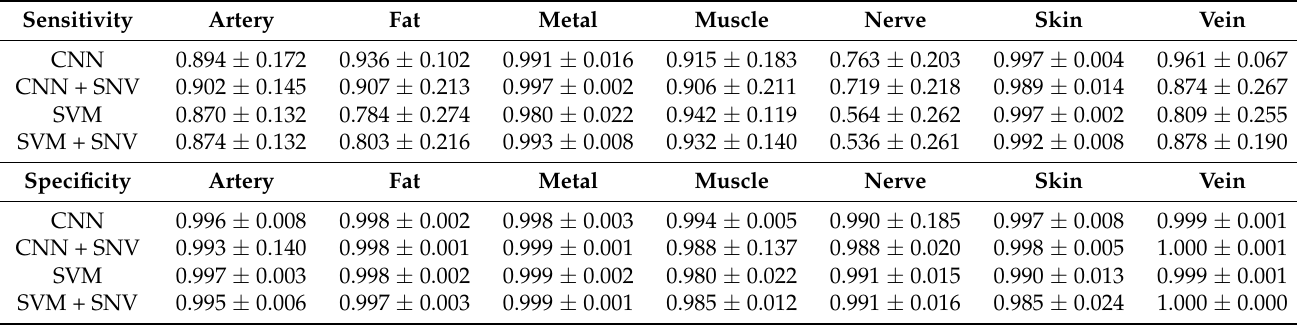
Table 1. Performance of the four classification models in terms of sensitivity ( top ) and specificity ( bottom ). Sensitivity